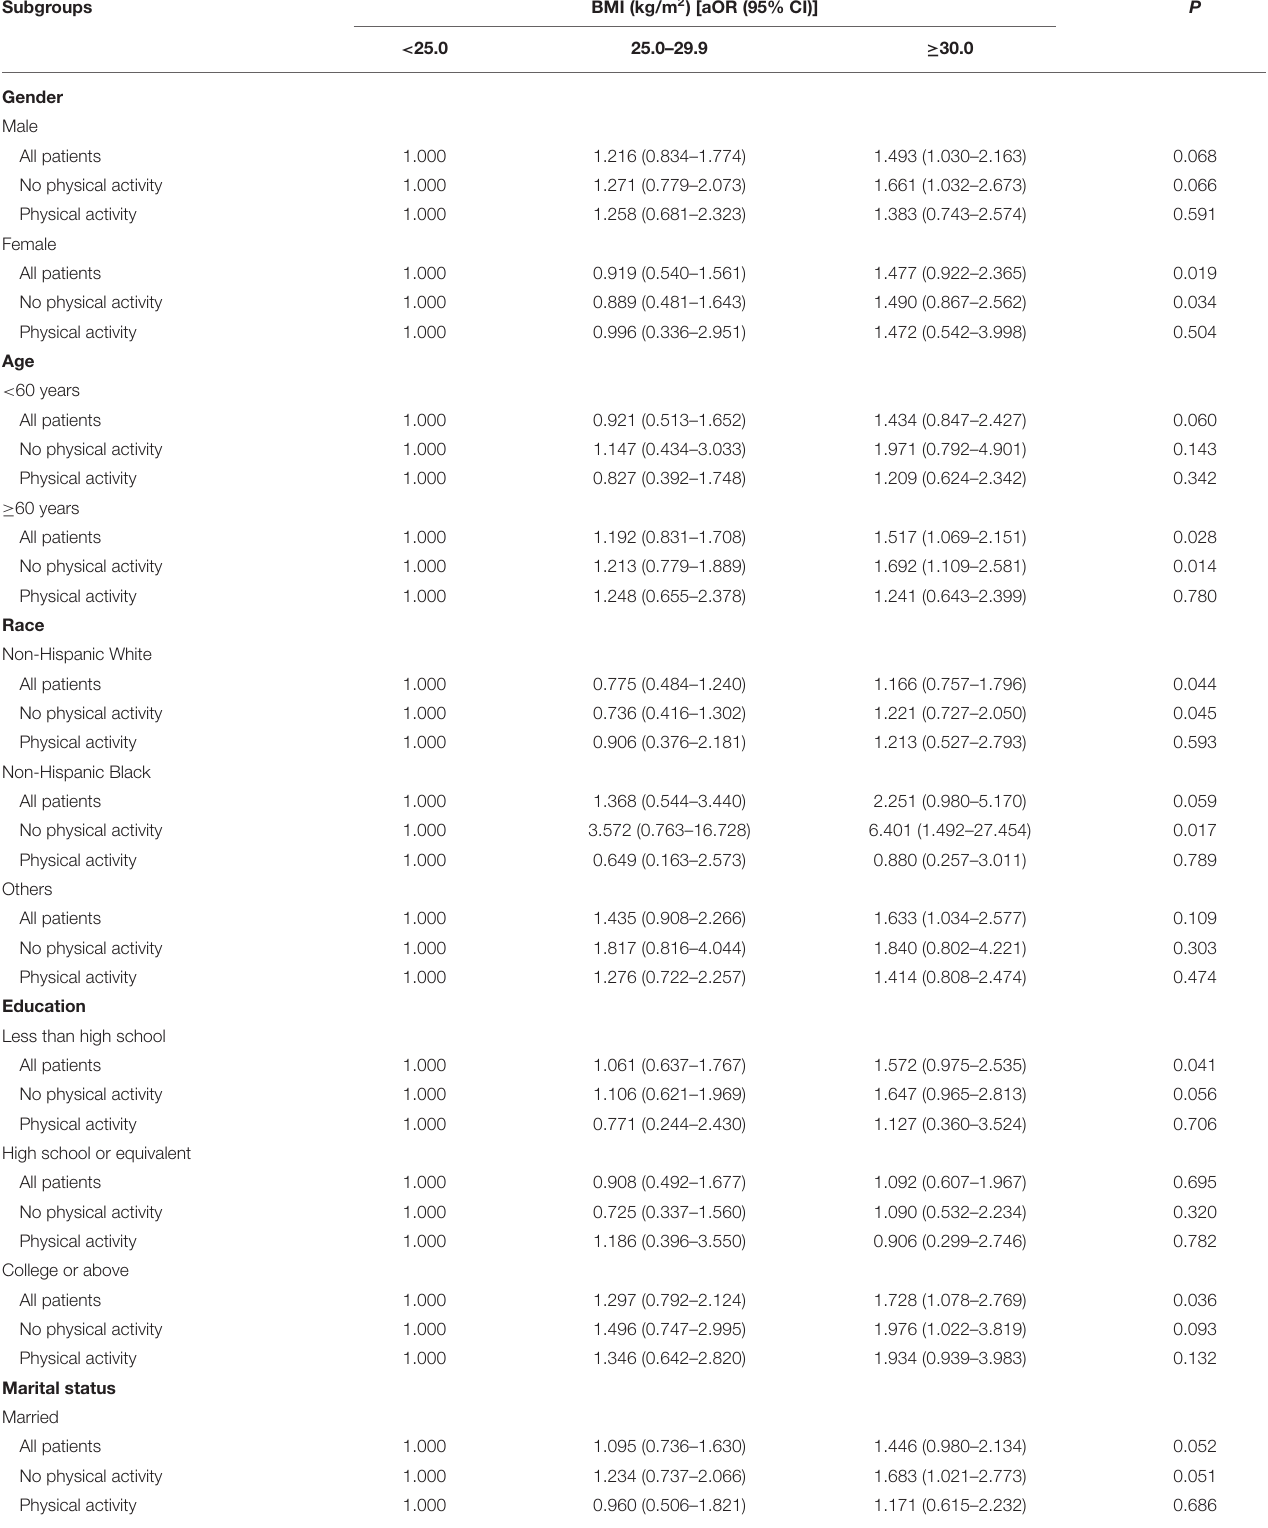
TABLE 4 | Subgroup analyses between BMI and the presence of kidney stone in NHANES 2007–2018.